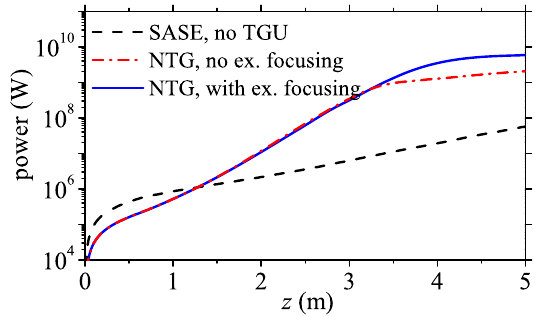
FIG. 3. FEL power around 3.9 nm for using natural transverse gradient (NTG, y 0 ¼ 0 . 5 mm) with (solid blue) and without (dashed dotted red) external focusing, comparing with normal SASE (dashed black). The external focusing is realized by adding two quadrupoles focusing in x plane ahead each of two 2.5-m undulator